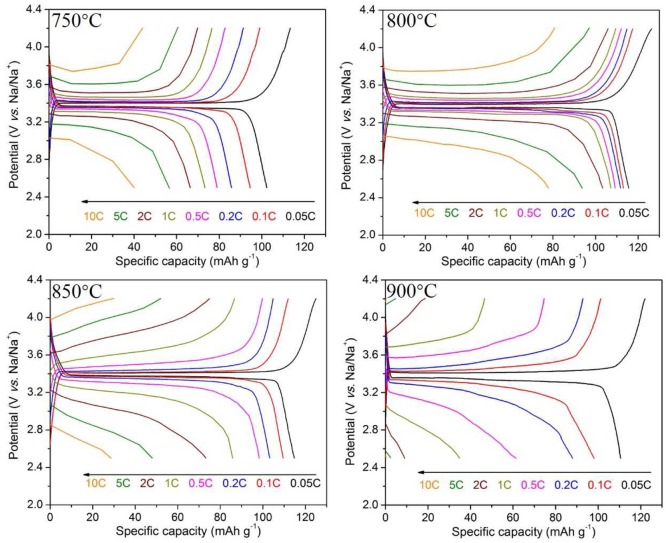
Charge/discharge curves of Na3V2(PO4)3/C synthesized at different temperatures.